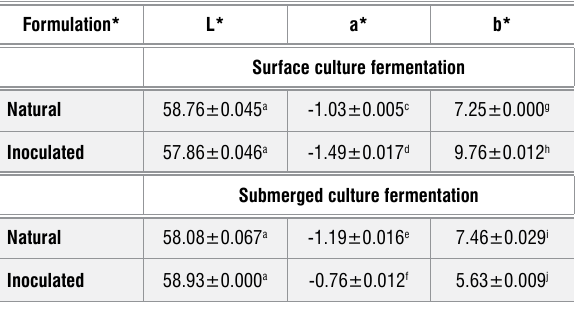
Chroma L*, a*, and b* values for marula vinegar produced by